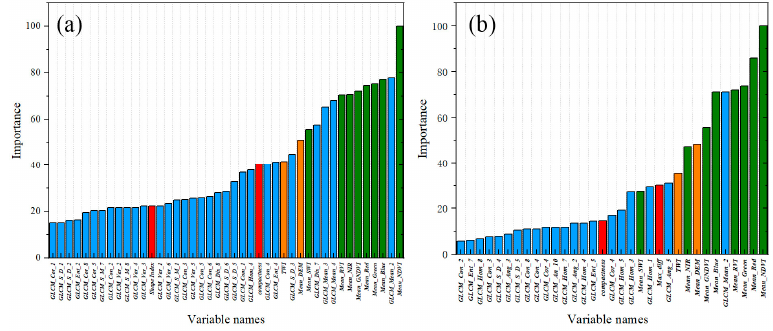
Figure 10. Input variables for scenario 4 using VSURF algorithm. ( a ) GF-1 data, ( b ) ZY-3 data. Table 9. Overall accuracy of trained RF model using VSURF-based variable selection. OA: overall accuracy; SD: standard deviation.